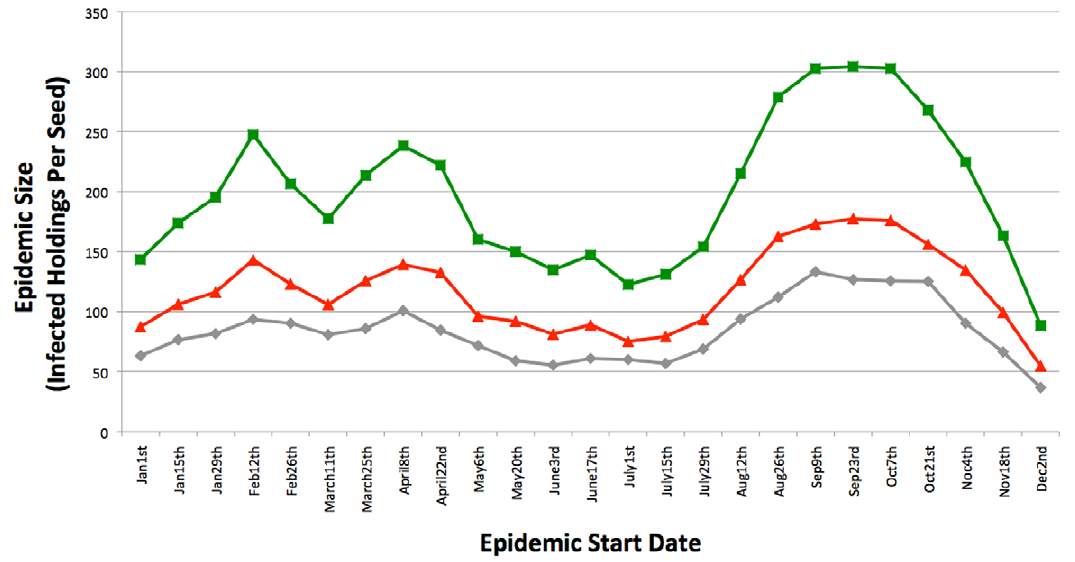
Figure 8. The effect of SOAs on epidemic size – source of infection. Each data point is the number of infected holdings per seed, generated from 400 stochastic simulations of FMD epidemics starting at that time of year, each with five seeds. The model keeps track of how each holding becomes infected, which can be via one of three routes: 1) Movements; 2) Local spread; and 3) Intra-SOA spread. The grey line shows the total number of infected holdings per seed for the normal Control model, with no SOAs or linked holdings. The grey line is therefore composed of Movement and Local spread infection events only. The red line shows the number of Movement and Local spread infection events (per seed) for the SOA model, which increases the size of epidemics throughout the year. However, the green line shows all (Movements + Local + intra-SOA) infection events (per seed) for the SOA model. As can be seen, the biggest contributor to the increase in epidemic size as a result of including SOAs is intra- SOA spread itself– other premises within the SOA becoming infected. Epidemic sizes are measured in terms of number of infected holdings – not number of infected animals.